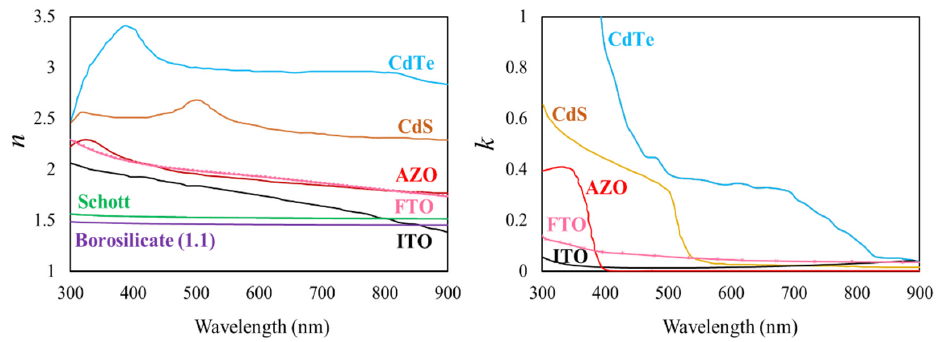
Figure 2. Refractive index ( n ) and extinction coefficient ( k ) of glass substrates (Schott/Borosilicate), Indium Tin Oxide (ITO), Fluorine Tin Oxide (FTO), Aluminum Zinc Oxide (AZO), Cadmium Sulfide (CdS), Cadmium Telluride (CdTe) thin films.